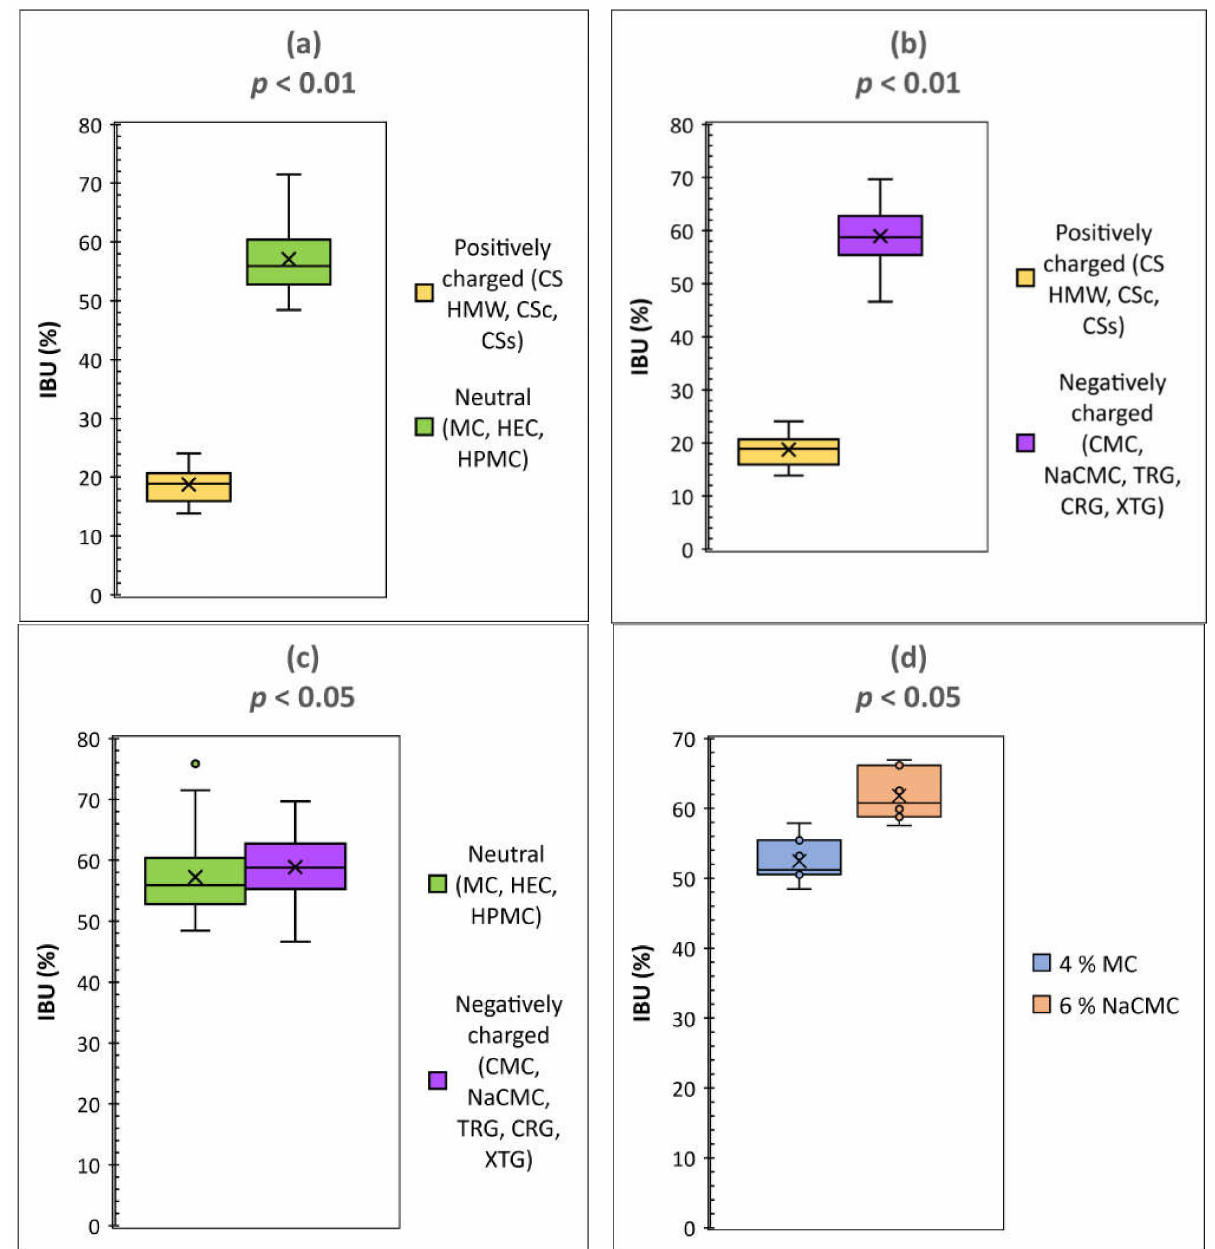
Figure 6. The statistical evaluation (Students’s t -test) of IBU release for particular groups of the hydrogels, characteristic by their charge. Comparison of ( a ) cationic hydrogels with neutral ones, p = 0.000, ( b ) cationic hydrogels with anionic ones, p = 0.000, ( c ) neutral hydrogels with anionic ones, p = 0.044, ( d ) neutral hydrogel (4% MC) with anionic one (6% NaCMC), having similar viscosities of 32.05 and 40.04 N.S m − 2 at shear rate 6.45 s − 1 , respectively, p =